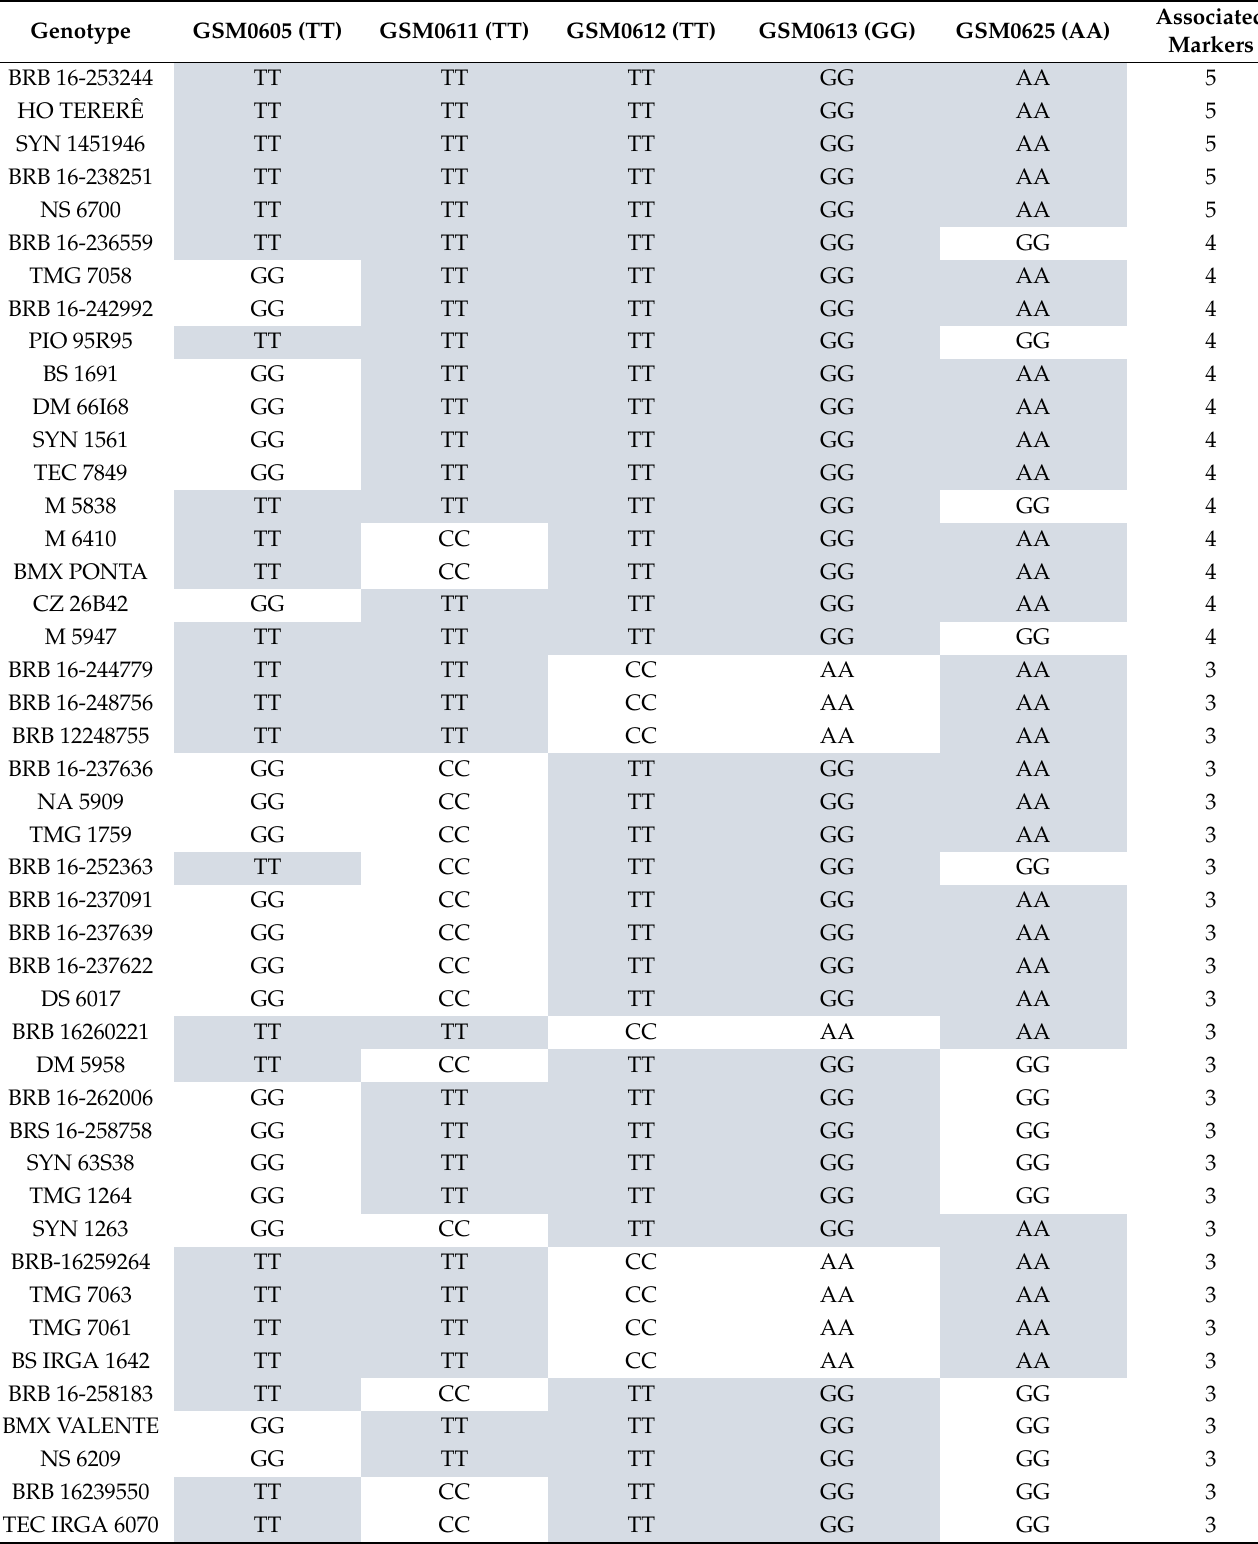
Table 9. Genotypes associated with greater tolerance to flooding for the five SNPs previously selected and